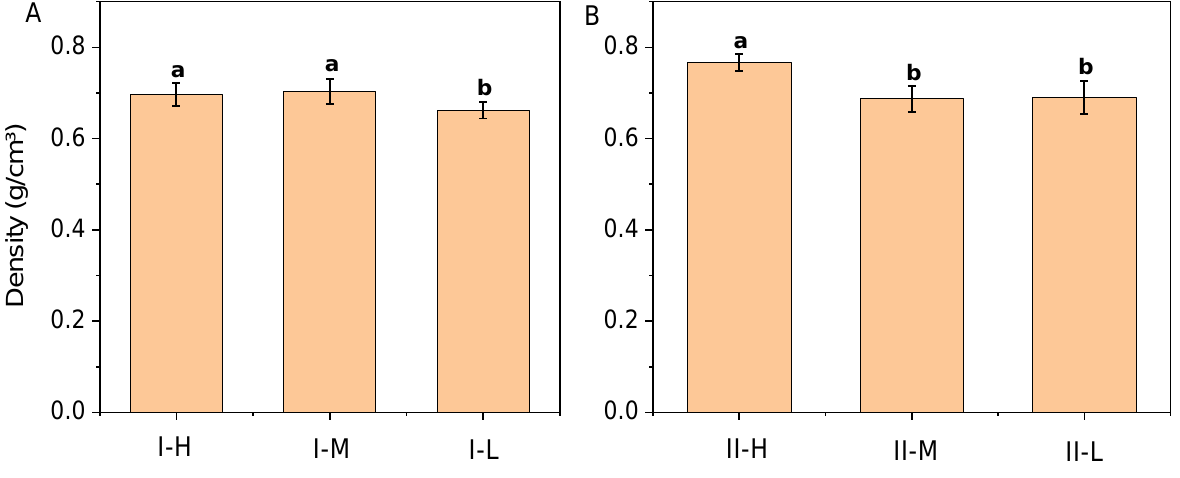
Figure 4. Average density of bamboo laminated composites: ( A ) parallel lamination (type I); and ( B ) cross lamination (type II). H, M, and L represent high, medium, and low fiber volumes, respectively, in the two types. Different letters within a column indicate significant differences as determined by Duncan’s multiple range test ( p < 0.05).